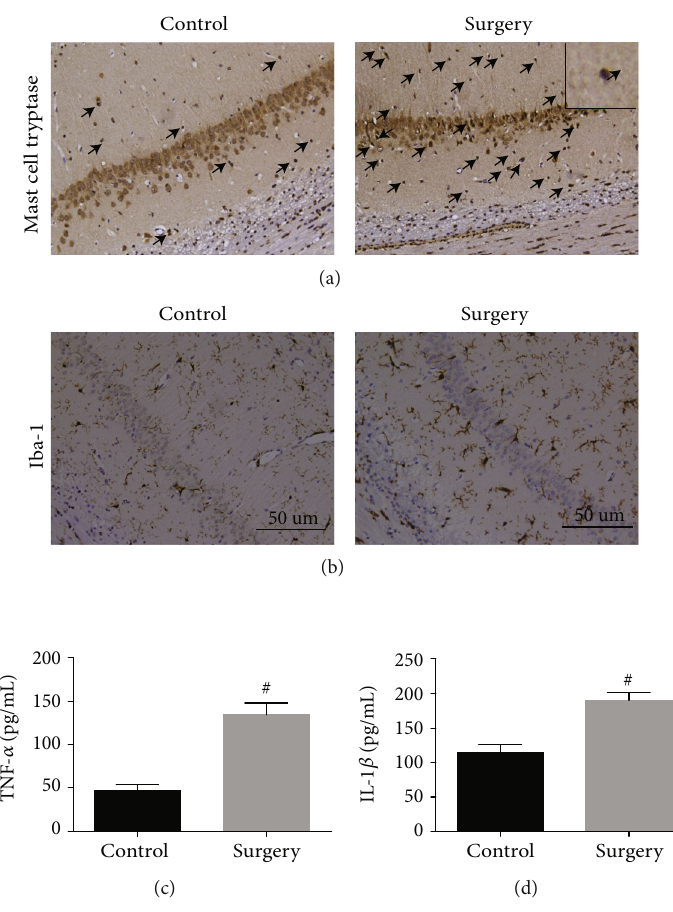
Figure 1: Surgery-induced mast cell degranulation and neuroin fl ammation in the hippocampus. (a) Mast cell tryptase in area CA1 of the hippocampus was detected by immunostaining. Scale bar is 50 μ m. (b) Immunostaining was used to test Iba1 in area CA1 of the hippocampus. Scale bar is 50 μ m. (c, d) ELISA was used to detect the expression of proin fl ammatory factors TNF- α and IL-1 β . # P < 0 : 05 versus control group. Data are presented as the mean ± SEM ( n = 5